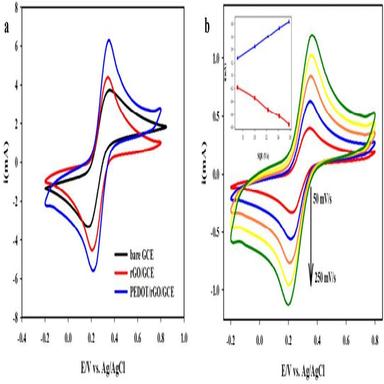
a) CV of modified electrode in 5 mM K4 of 1.0 M KCl solution at 100 mV/s scan rate and (b) CV of PEDOT/rGO/GCE recorded at different scan rate (Inset: linear relationship of redox peak with square root of scan rate).